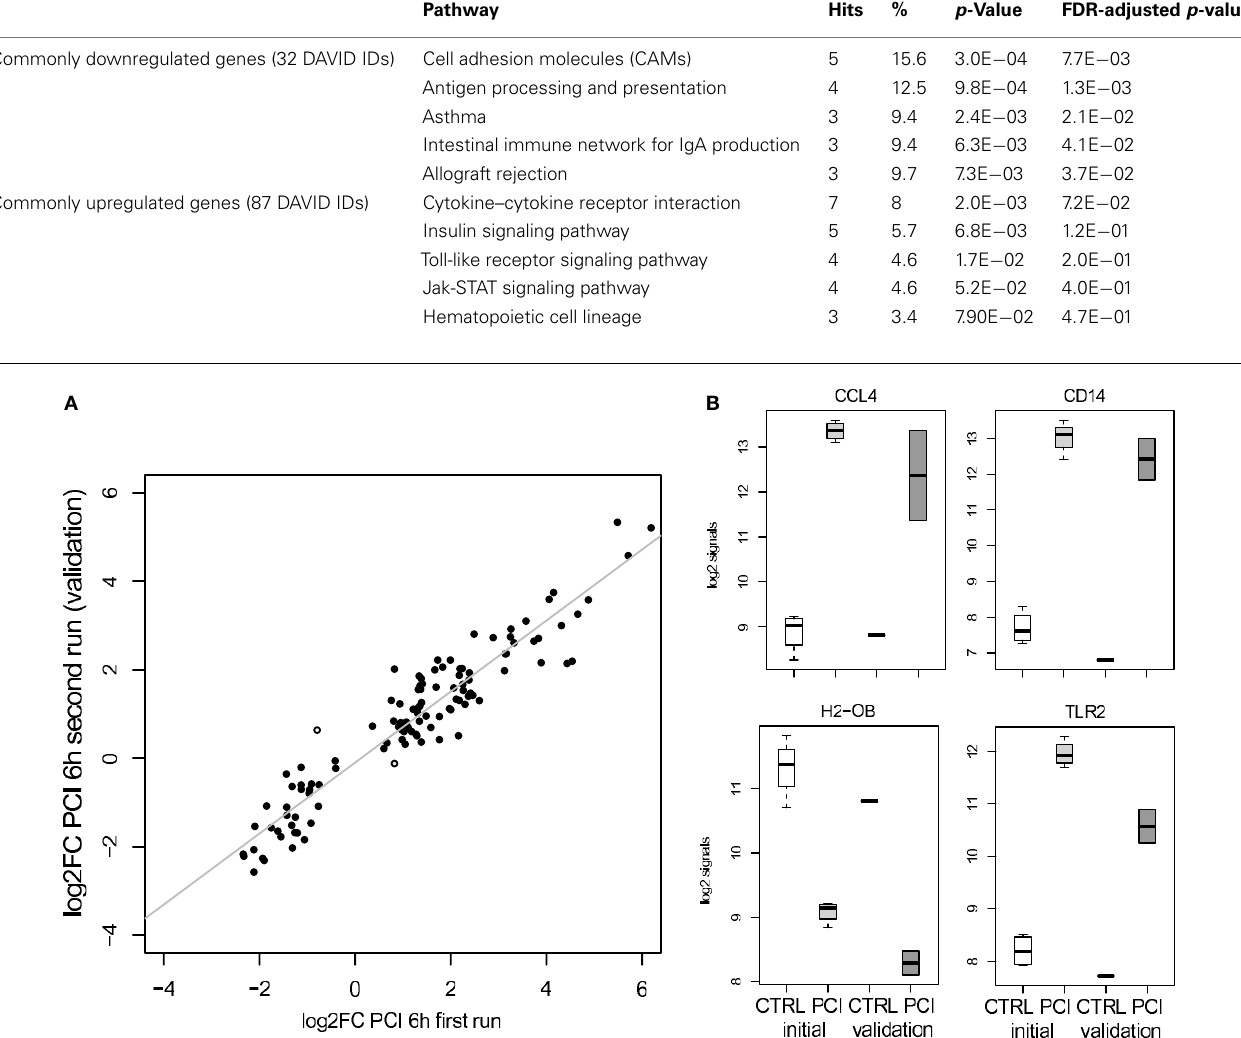
Table 2 |Top five enriched KEGG pathways obtained from DAVID ( p -values Fisher’s exact test p < 0.05) supported by FDR-adjusted p -values within the common down- and upregulated DEG from PCI and PICU.